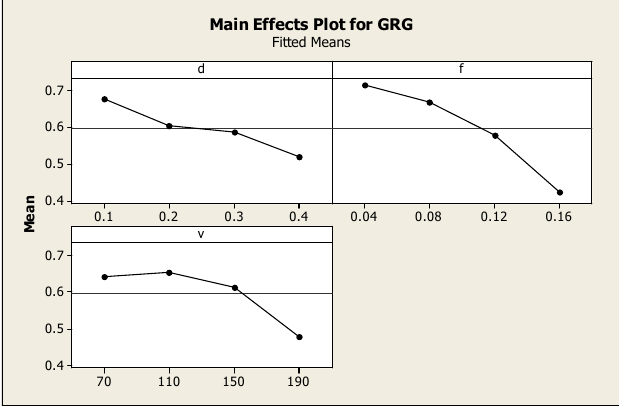
Fig.5. Main effect plot of grey relational grade